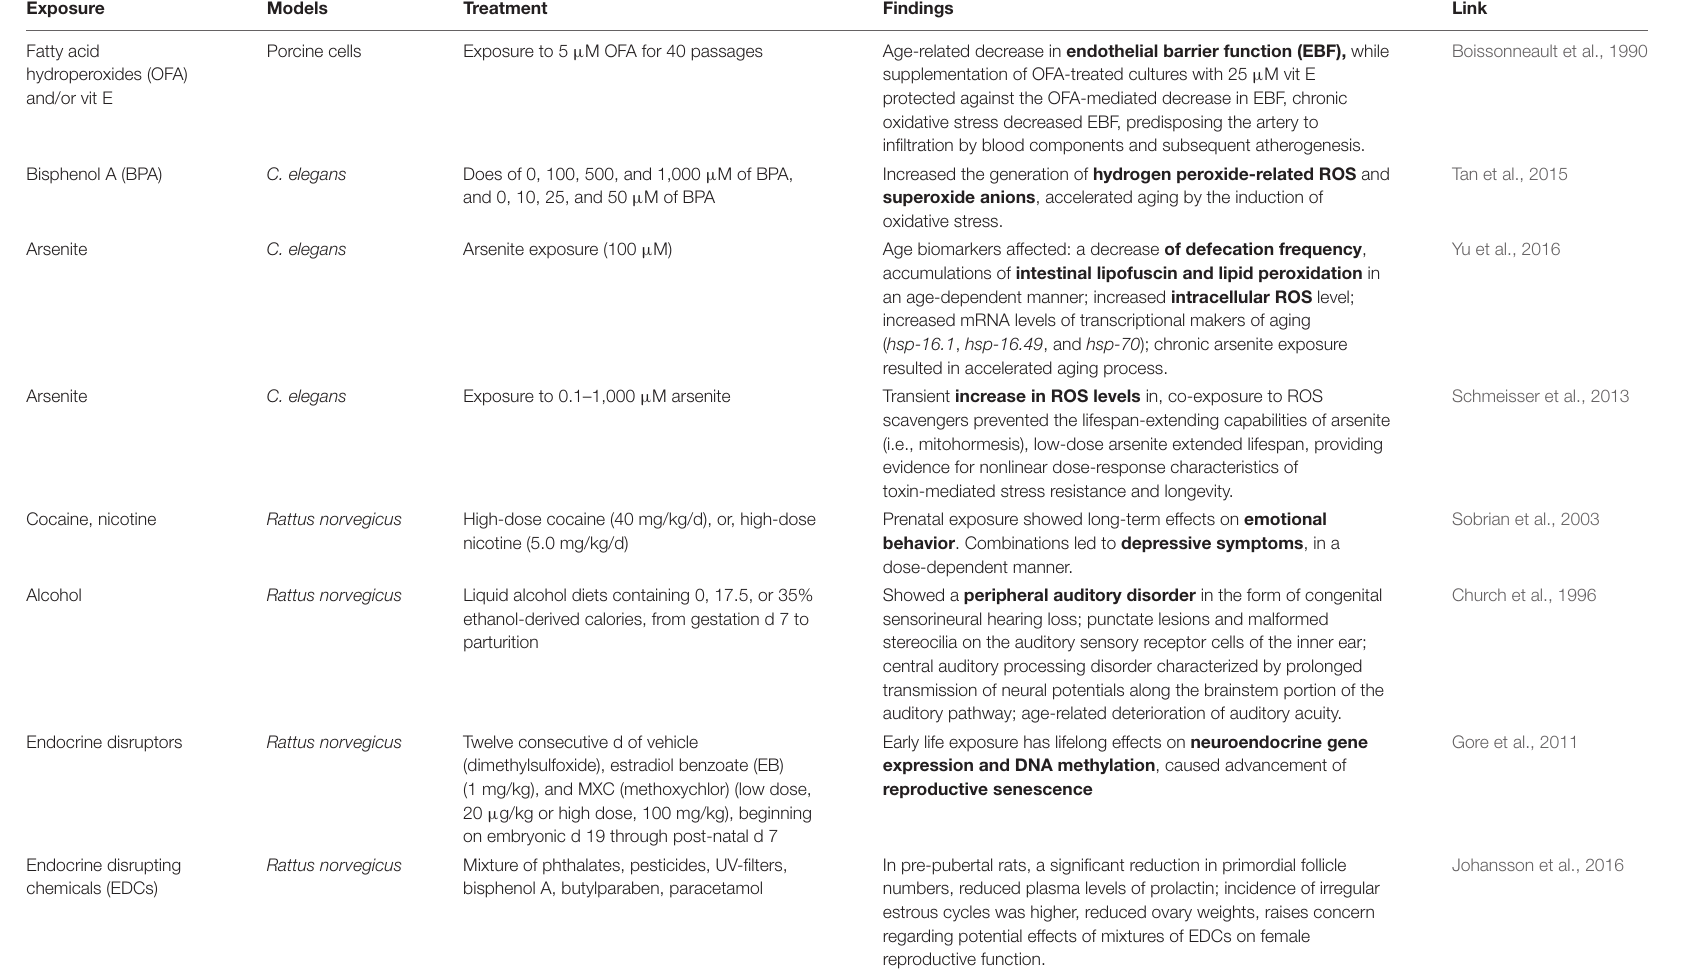
TABLE 2 | List of studies that looked at exposure and its effect on aging in animal models. Exposure Models Treatment Findings Link Fatty acid Porcine cells Exposure to 5 µ M OFA for 40 hydroperoxides (OFA) and/or vit E